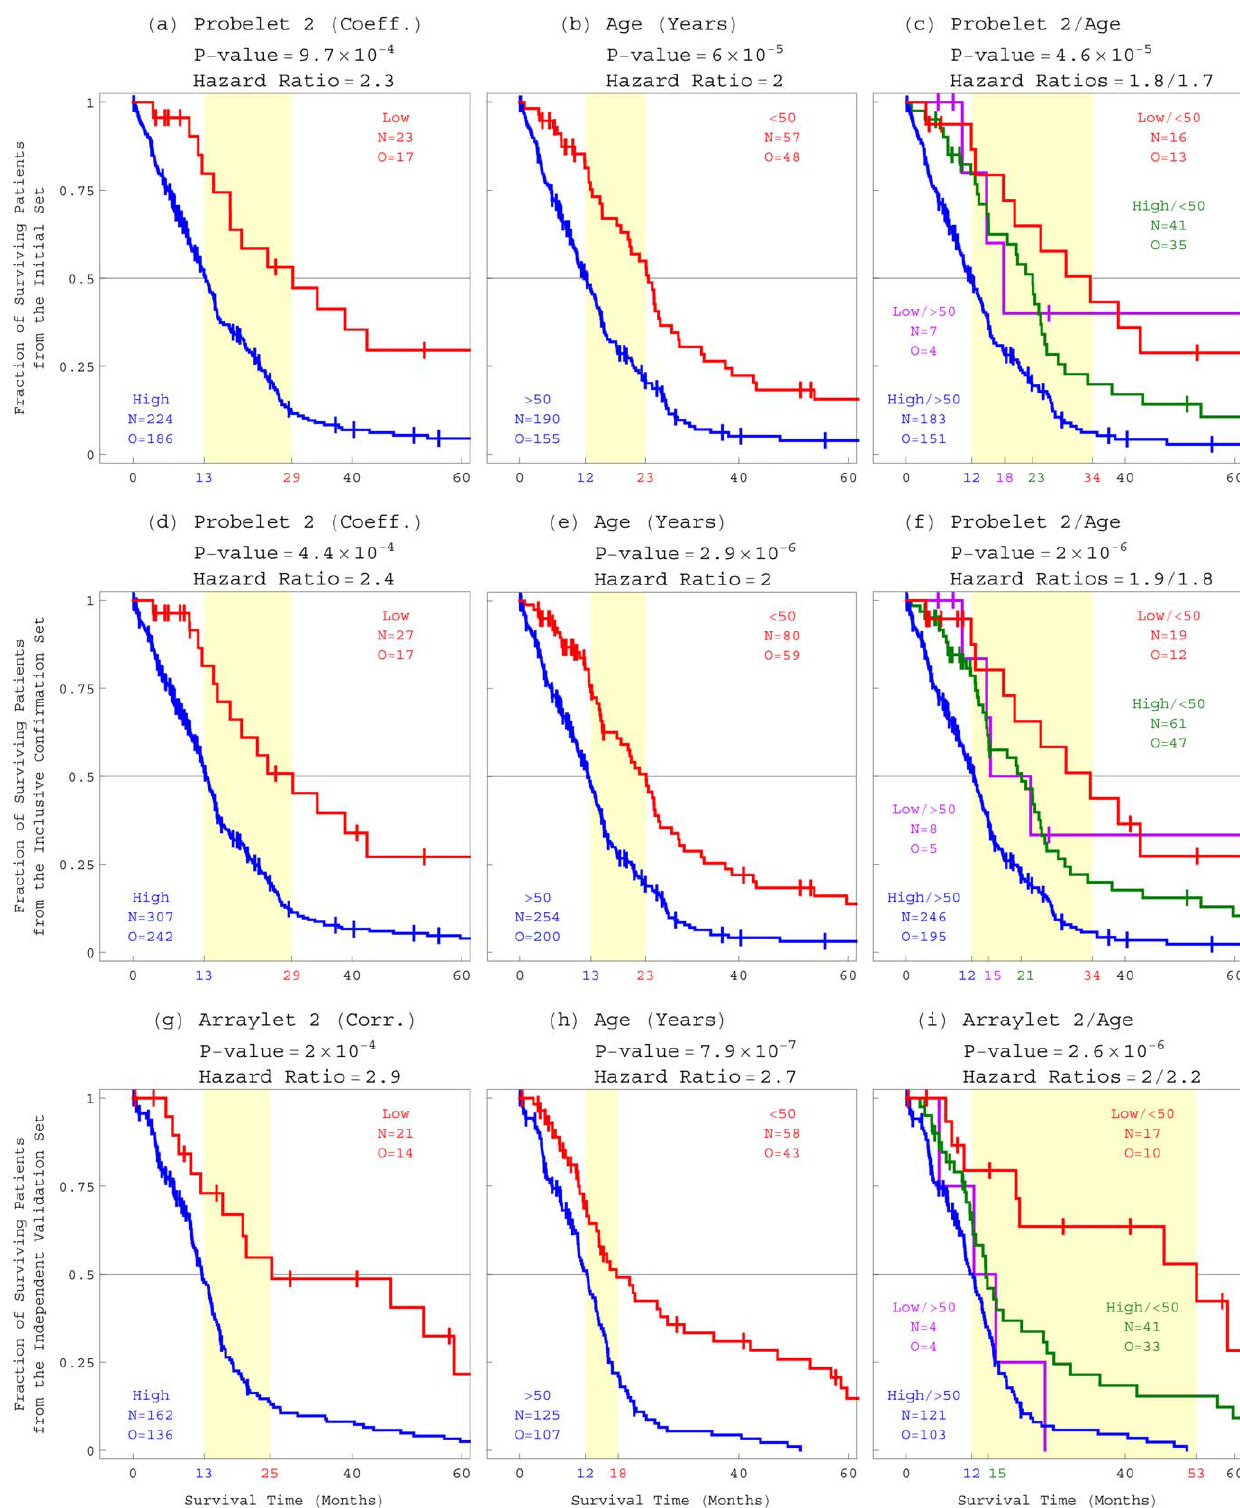
Figure 3. Survival analyses of the three sets of patients classified by GSVD, age at diagnosis or both. ( a ) Kaplan-Meier (KM) [36] curves for the 247 patients with TCGA annotations in the initial set of 251 patients, classified by copy numbers in the second probelet, which is computed by GSVD for the 251 patients, show a median survival time difference of * 16 months, with the corresponding log-rank test P -value v 10 { 3 . The univariate Cox [37] proportional hazard ratio is 2.3, with a P -value v 10 { 2 (Table S1), meaning that high relative copy numbers in the second probelet confer more than twice the hazard of low numbers. The P -values are calculated without adjusting for multiple comparisons [38]. ( b ) Survival analyses of the 247 patients classified by age, i.e., w 50 or v 50 years old at diagnosis, show that the prognostic contribution of age, with a KM median survival